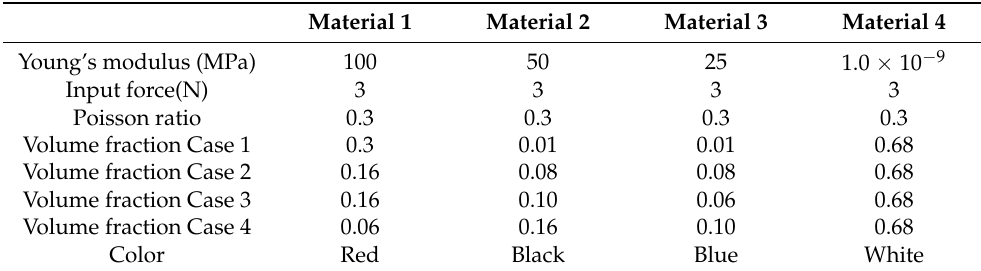
Table 3. Design parameters for the compliant gripper.